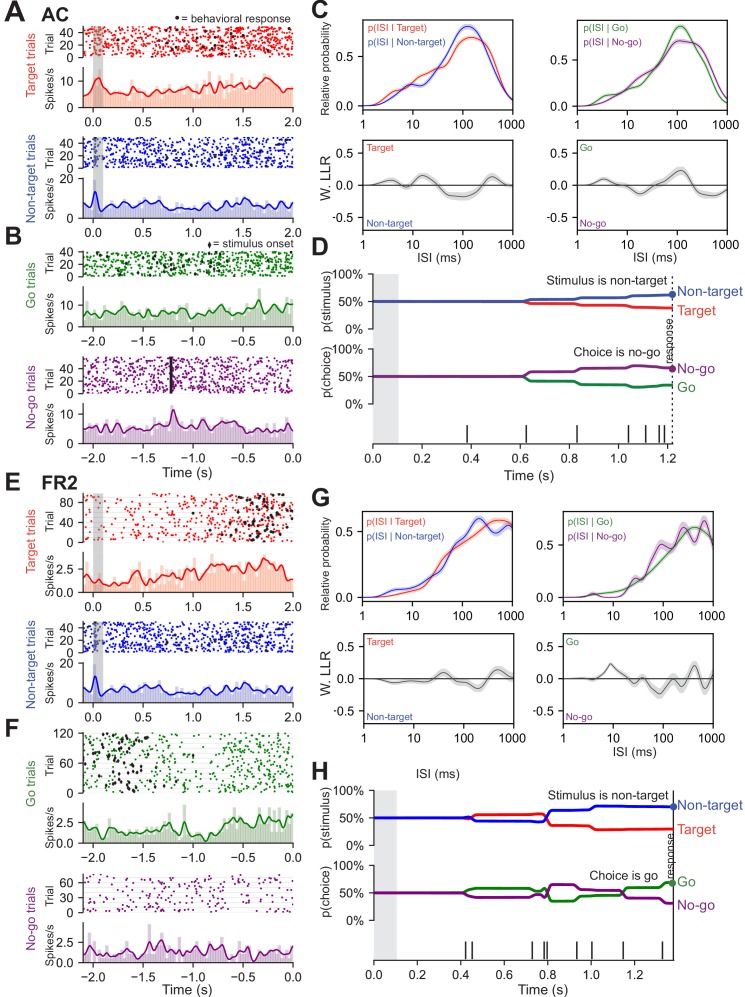
Decoding algorithm to determine stimulus category and choice in single-unit ISIs from AC and FR2 for two additional neurons.(A–D) Decoding algorithm applied to a sample neuron in AC. (A) Single-unit activity sorted by stimulus condition: target trials (red) and non-target trials (blue). Black circles represent the behavioral response. (B) Trials aligned to behavioral response: go (green) and no-go (purple). Black diamonds in both go and no-go trials represent stimulus onset. (C) All ISIs during the trial (following stimulus onset and before behavioral choice) are aggregated into libraries for each condition (average response time is used on no-go trials). Probability of observing a given ISI on each condition was generated by using Kernel Density Estimation on the libraries from (A). Top left are target (red) and non-target (blue) probabilities and on right are go (green) and no-go (purple). Below left (right) are the log likelihood ratios (LLR) for the ISIs conditioned on stimulus category (behavioral choice). When curve is above zero the ISI suggests target (go); when it is below zero the ISI suggests non-target (no-go). (D) Probability functions from c were used as the likelihood function to estimate the prediction of a spike train on an individual trial (bottom). Bayes’ rule was used to update the probability of a stimulus (top) or choice (bottom) as the trial progresses and more ISIs were observed. Prediction for the trial was assessed at the end of the trial as depicted by the highlighted dot. (E–H) as in (A–D) except the decoding algorithm is applied to a neuron from FR2.